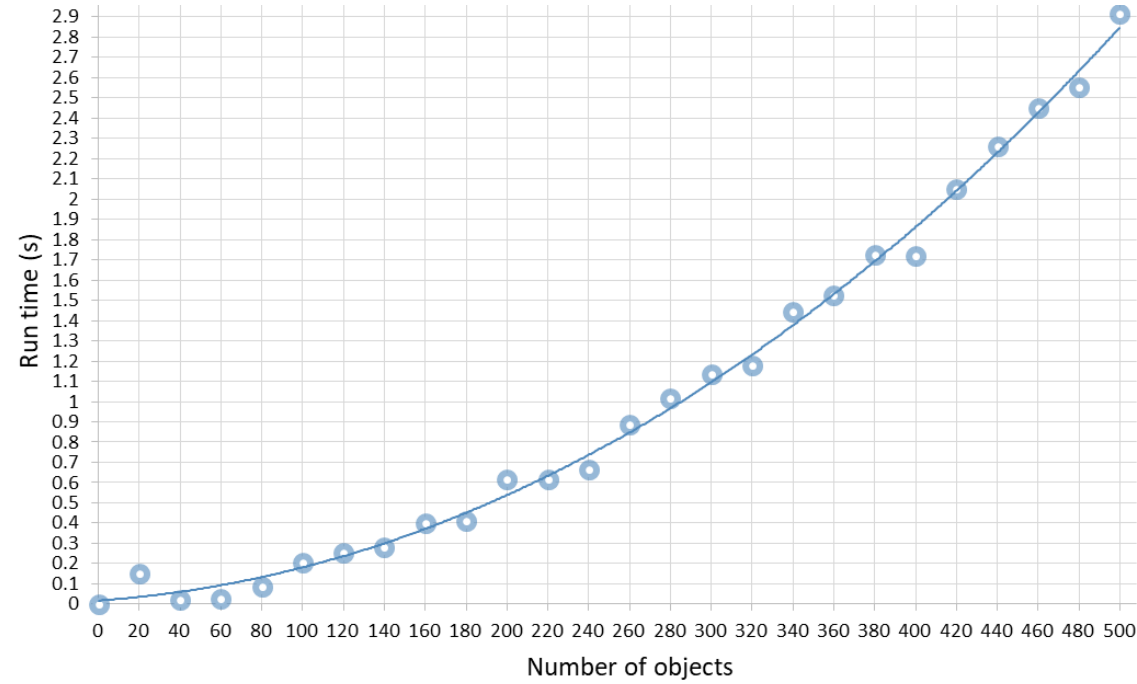
Figure 3. Dependence of the formation time of the matrix M on its dimension.